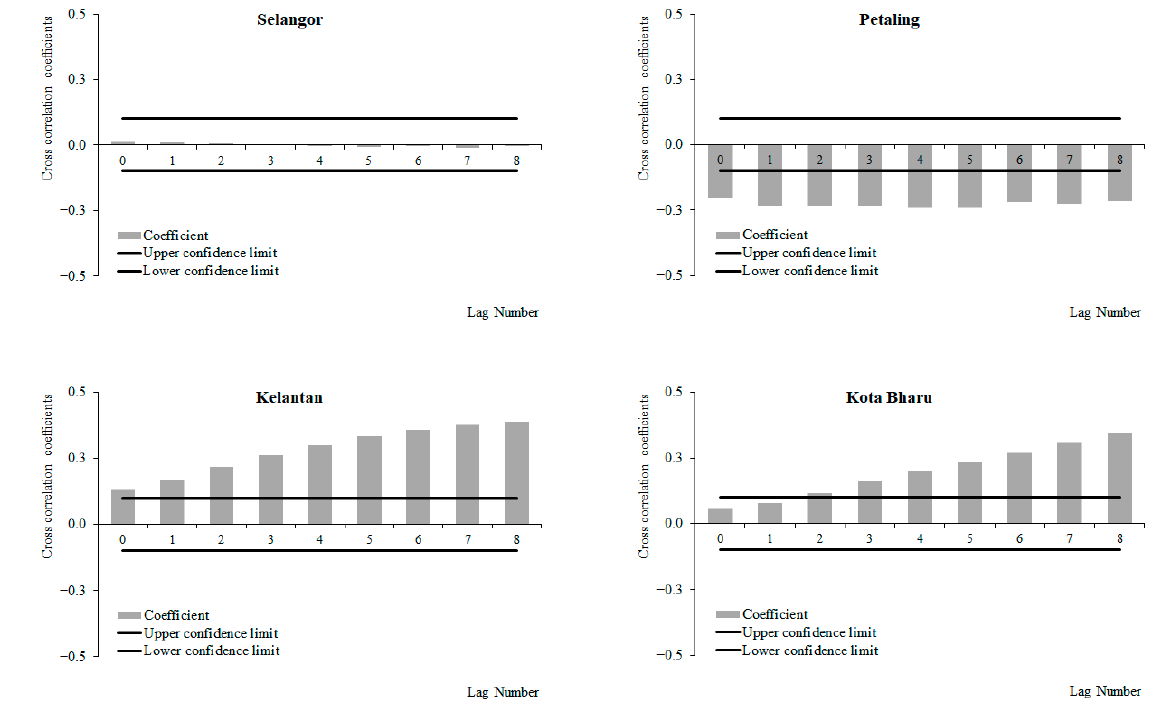
Figure 11. Cross-correlation function between dengue cases and temperature in Selangor, Petaling, Kelantan and Kota Baharu, 2011 to 2014.